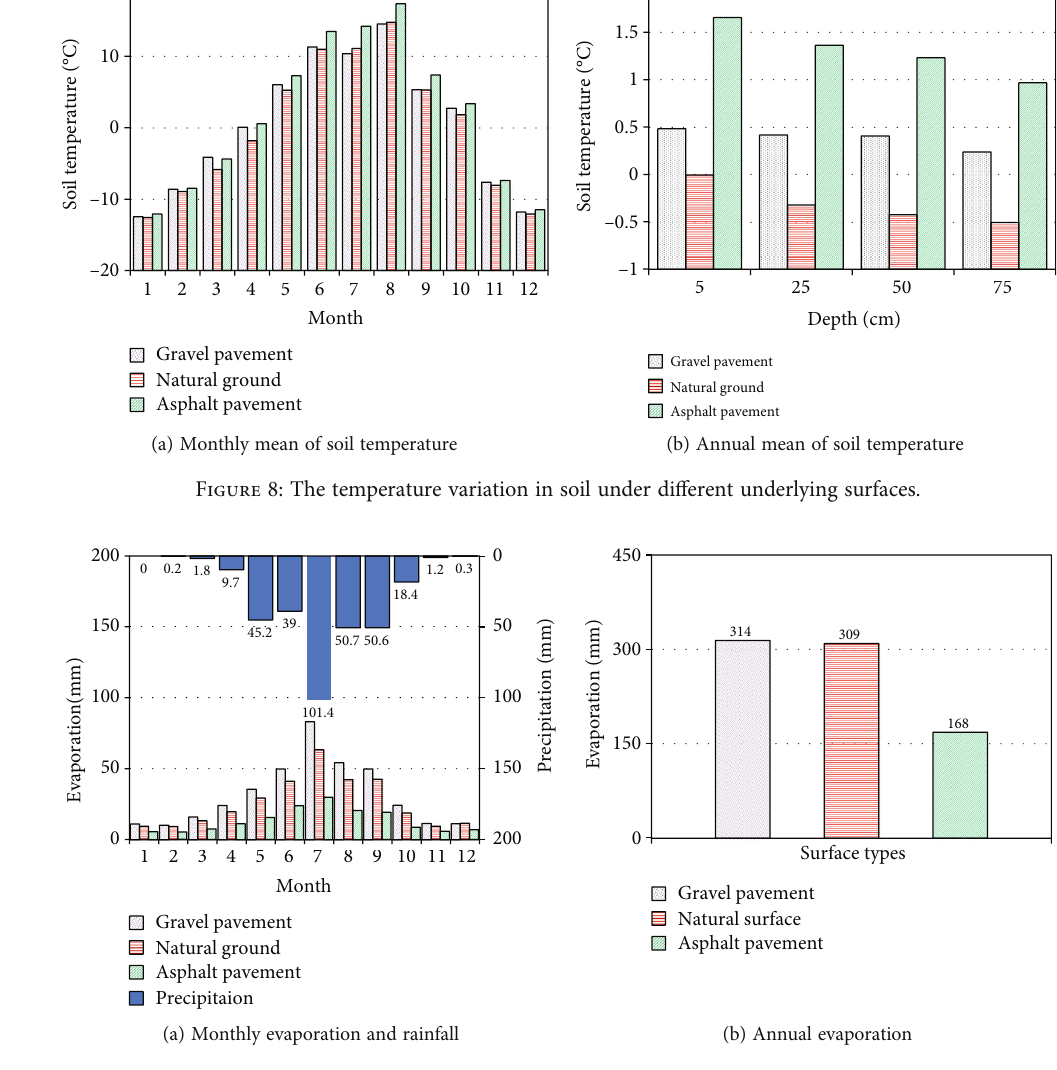
Figure 9: Surface evaporation of di ff erent underlying surfaces and rainfall.